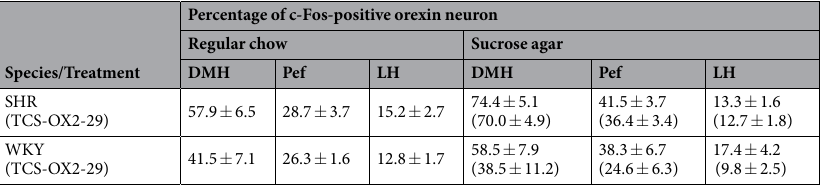
Table 1. Percentages of c-Fos-positive orexin neurons following food consumption in spontaneously hypertensive rats (SHR) and Wistar-Kyoto rats (WKY). Data are expressed as the mean ± SEM (n = 4 in all groups). TCS-OX2-29 treatment was applied in sucrose-agar treated SHR and WKY and the data were shown in brackets. Statistical analysis was performed for each nucleus among experimental groups (not including TCS-OX2-29) with one-factor ANOVA followed by Duncan’s multiple-range test. Effects of TCS-OX2-29 were analyzed with a t -test. No significance was found. Abbreviation: DMH, dorsomedial hypothalamus; Pef, perifornical hypothalamus; LH, lateral hypothalamic